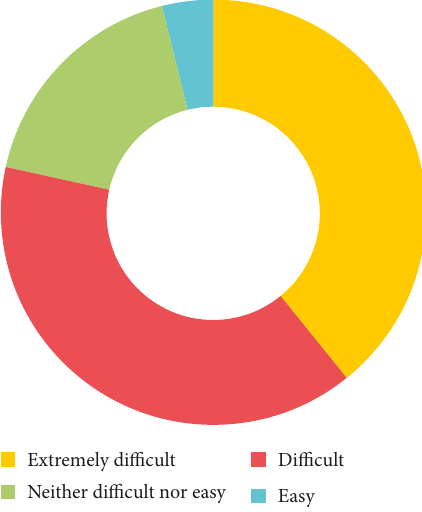
Figure 4: Visual representation of percentages of responses in Question 2.